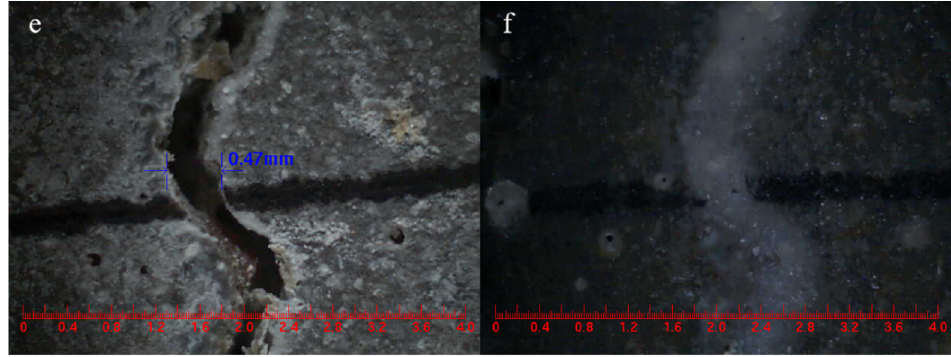
Figure 15. Surface cracks width of mortars. ( a ) SJ-0, ( b ) SJ-0 for 15 days self-repairing, ( c ) SJ-1, ( d ) SJ-1 for 15 days self-repairing, ( e ) SJ-2, ( f ) SJ-2 for 15 days self-repairing.